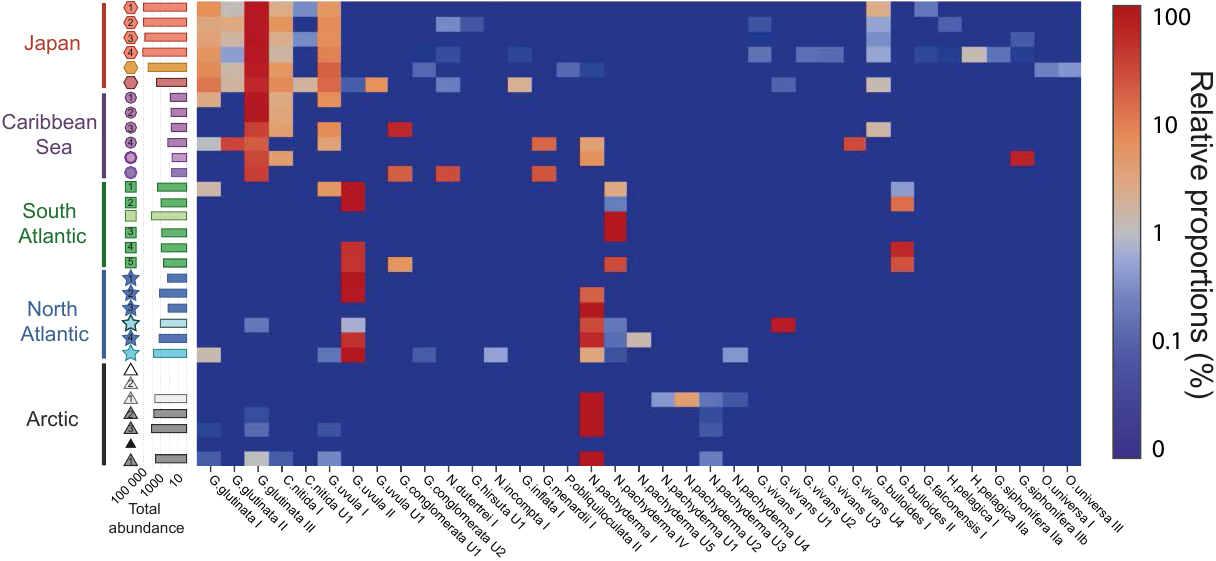
Figure 3. Heat Map of the relative proportions of the genetic types detected in the 31 samples. The histogram on the left side of the heat map indicates the total abundance in log value of the reads belonging to planktonic foraminifera. Symbols as in Figs.